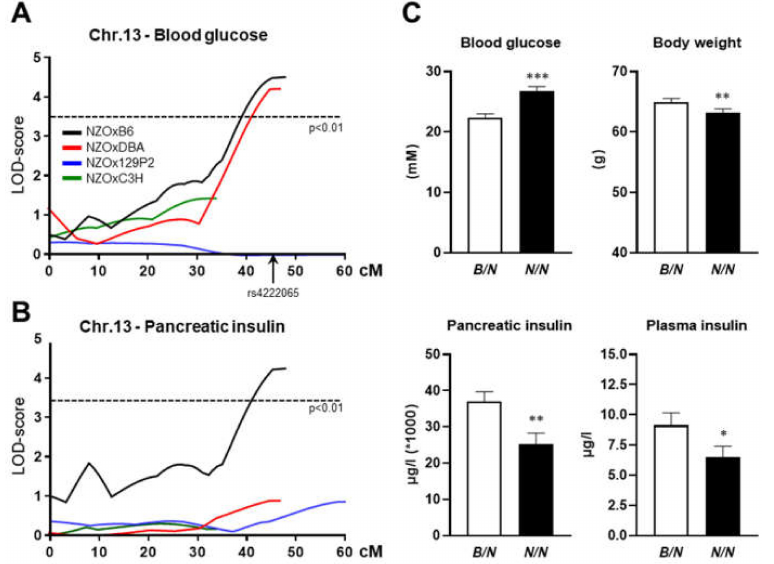
Figure 1. Physical maps of the QTL Nidd13/NZO identified by genome-wide linkage analysis of NZO backcross populations. Genome-wide linkage analysis for the traits blood glucose ( A ) and total pancreatic insulin ( B ) revealed a single QTL on chromosome 13. The analysis was performed with data from male mice of the different N2 populations. The horizontal line indicates the threshold of significance ( p < 0.01). ( C ) Effect sizes of traits associated with the QTL Nidd13/NZO in the (NZOxB6)N2 cohort ( N/B : n = 148; N/N : n = 139). Data are presented as means ± SEM. * p < 0.05; ** p < 0.01; *** p <